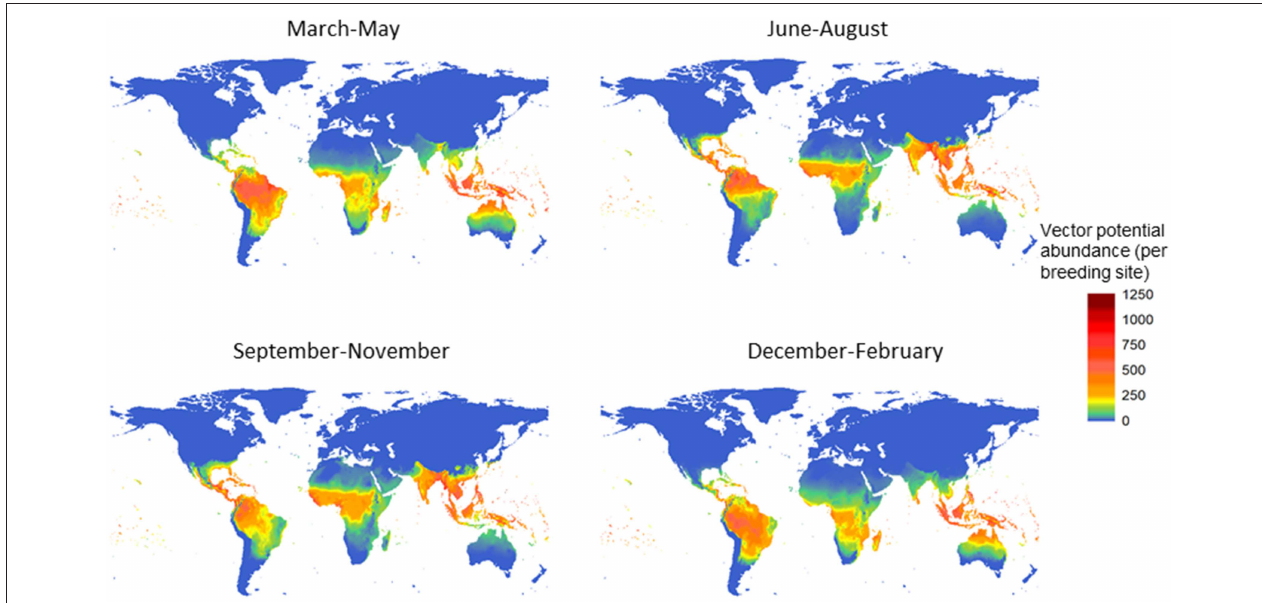
FIGURE 1 | Potential for global distribution and abundance of female Aedes aegypti over the decade 2000–2009, by season. The vector population was first summarized for each season − 3 months-and then averaged over the decade. The unit is vector population per larval site, and model A was used.